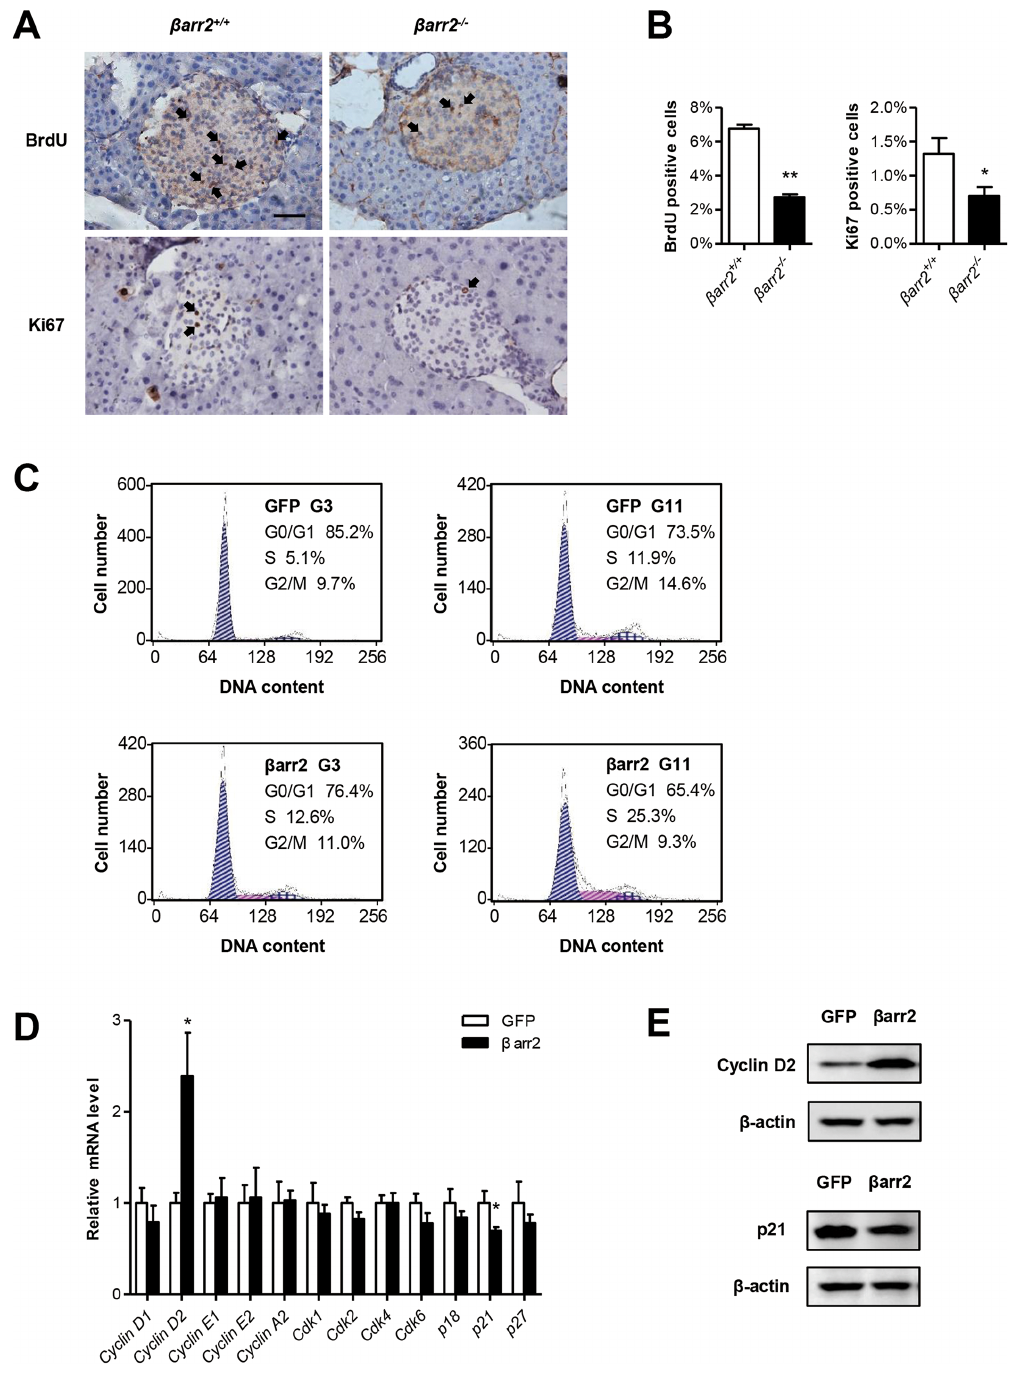
Figure 4. The effect of β arr2 on β -cell proliferation. (A) Representative micrographs of BrdU and Ki67 staining in islets of b arr2 +/+ and b arr2 –/– mice. Scale bar: 50 μ m. Arrows: BrdU- or Ki67-positive cells. (B) Quantification of BrdU- or Ki67-positive cells in the total islet cells (n = 3–5). (C) Cell cycle distribution analyzed by flow cytometry in INS-1 (832/13) cells infected with adenovirus expressing GFP or b arr2 and exposed to 3 mmol/L (G3) or 11 mmol/L (G11) glucose. (D) Relative mRNA transcriptional levels of cell cycle genes from INS-1 (832/13) cells with β arr2 overexpression (n = 6–8). Expression of mRNA was normalized with b -actin . (E) Cyclin D2 and p21 protein levels in INS-1 (832/13) cells infected with adenovirus expressing GFP or β arr2. Pictures are representative of four independent experiments. * P < 0.05, ** P < 0.01, versus